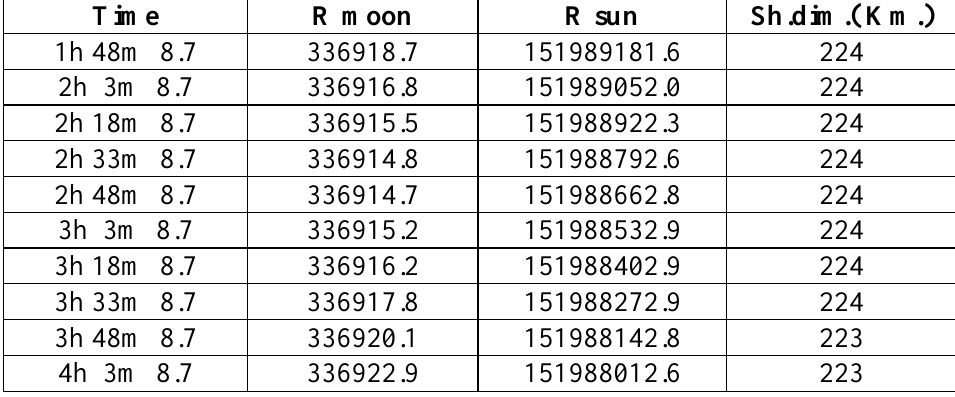
Table (11-b): YY = 0.077345662990 Total CENTRAL